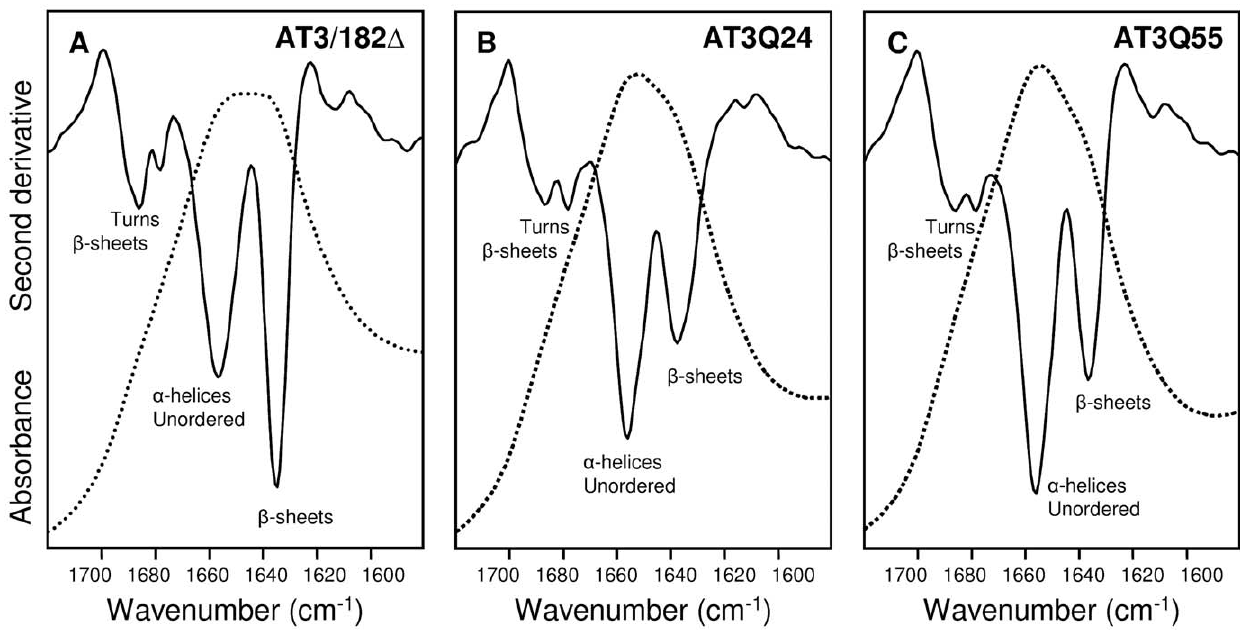
Figure 2. FTIR spectra of freshly purified AT3 variants. Absorption spectra (dotted line) and their second derivatives (continuous line) in the amide I region of AT3 variants: JD (A), AT3Q24 (B), and AT3Q55 (C). Band assignment to the secondary structure components is indicated.